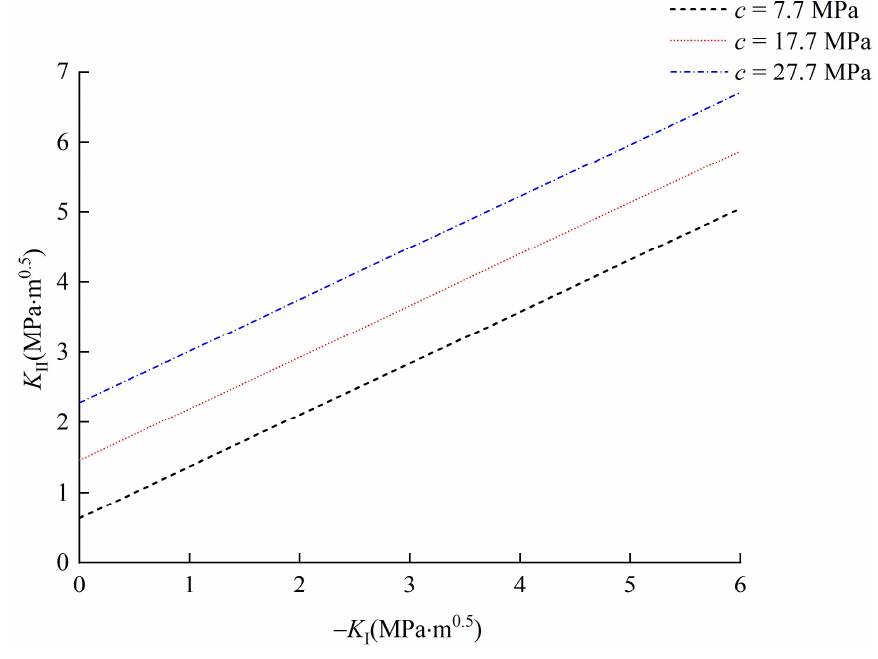
Figure 10. Effect of c on the initiation of interface crack.